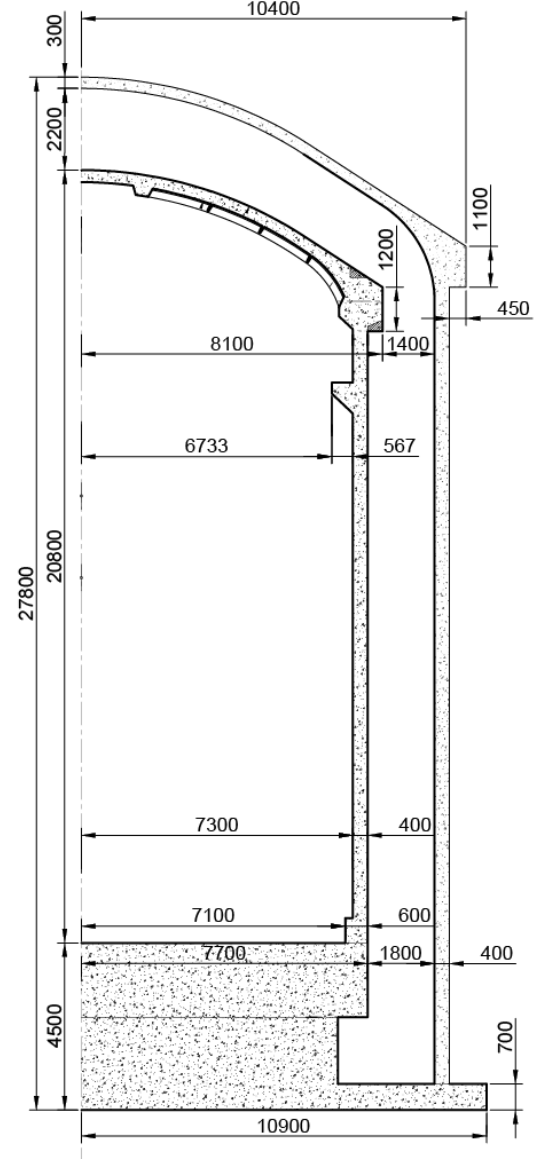
Figure 1. Section of the CCB VERCORS mock-up [1], dimensions in [mm].